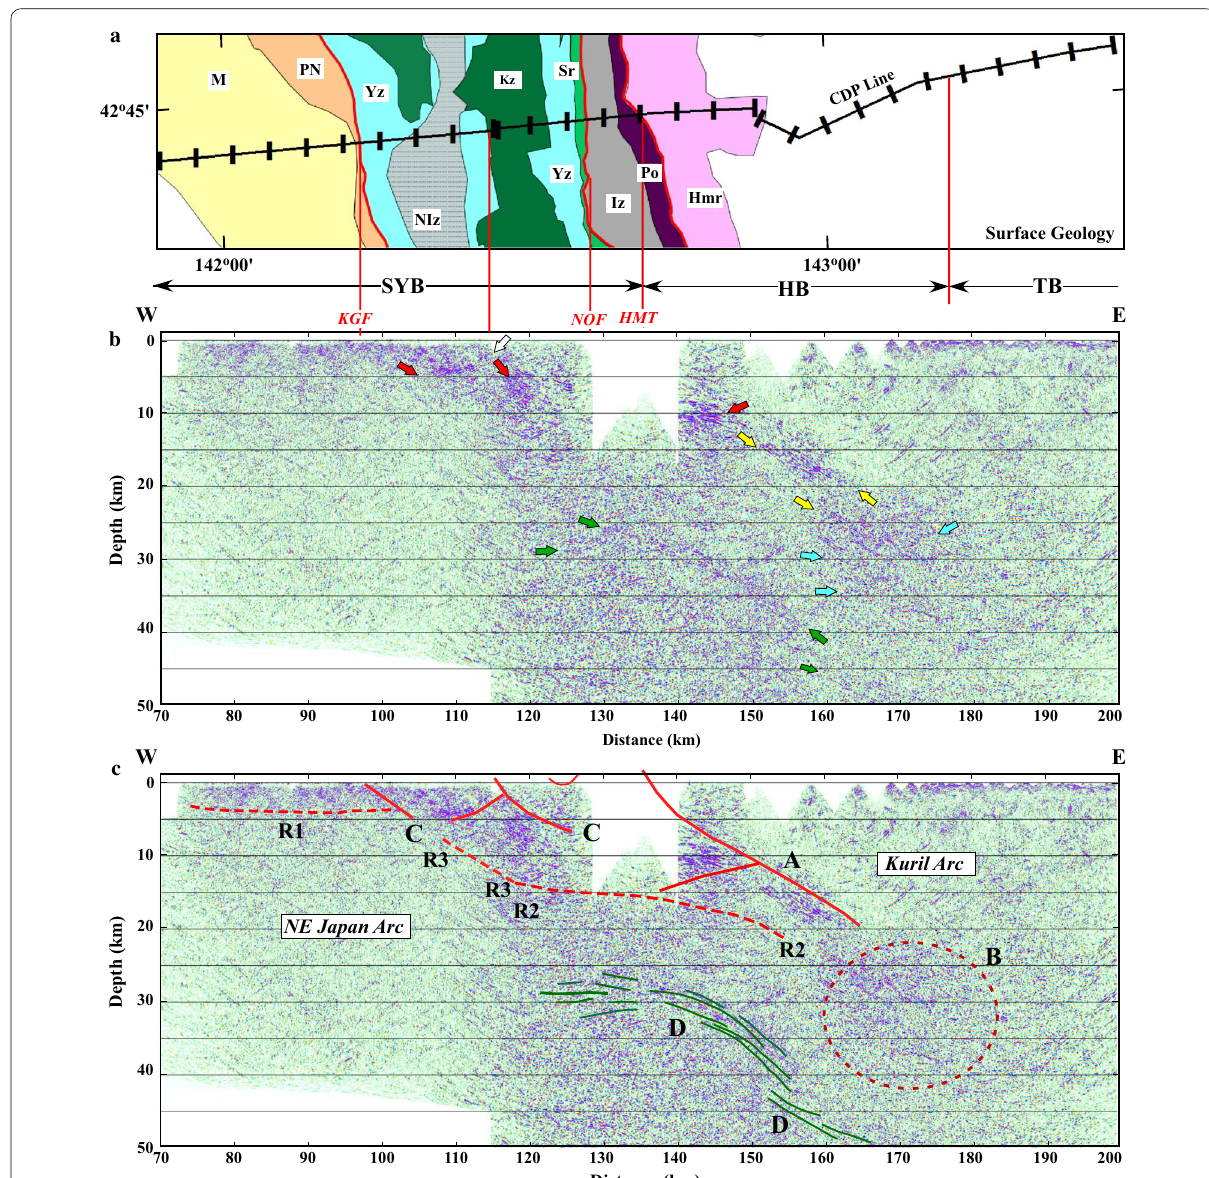
Fig. 2 Surface geology and depth-migrated section. a Surface geology. Hmr: Hidaka metamorphic rocks; Po: Poroshiri Ophiolite; Iz: Idon’nappu zone; Sr: Sorachi Group; Yz: Yezo Group; Kz: Kamuikotan zone; NIz: Nappe of Iz; PN: Poronai Group; M: Miocene strata; HMT: Hidaka Main Thrust; NOF: Nitarachi-Oshorobetsu fault; KGF: Kenomai-Gabari fault. b Depth-migrated section from 1998–2000 seismic reflection data using CRS/MDRS method (see the text for detailed explanation). Yellow allows show eastward dipping events beneath the HB. This domain is traced down to a 20–25-km depth. At depths of 25–40 km beneath the HMT, several uncoherent events are recognized (light blue arrows). West-verging events in the uppermost 15-km crust west of the HMT are also noticed (red arrows). A white arrow is the uppermost event dipping to the west. c Depth-migrated section from 1998–2000 seismic reflection data with our interpretations (red lines). “A” indicates the deeper image of the HMT. Uncoherent events around the bottom of the HMT are enclosed by a broken ellipse (“B”). West-verging events in the uppermost crust are indicated by “C”. Deep structures in the NE Japan Arc are shown by green lines (“D”). Red broken lines (“R1” to “R3”) are structural boundaries interpreted with aid of the velocity structure model from the refraction/wide-angle reflection data (see Fig.